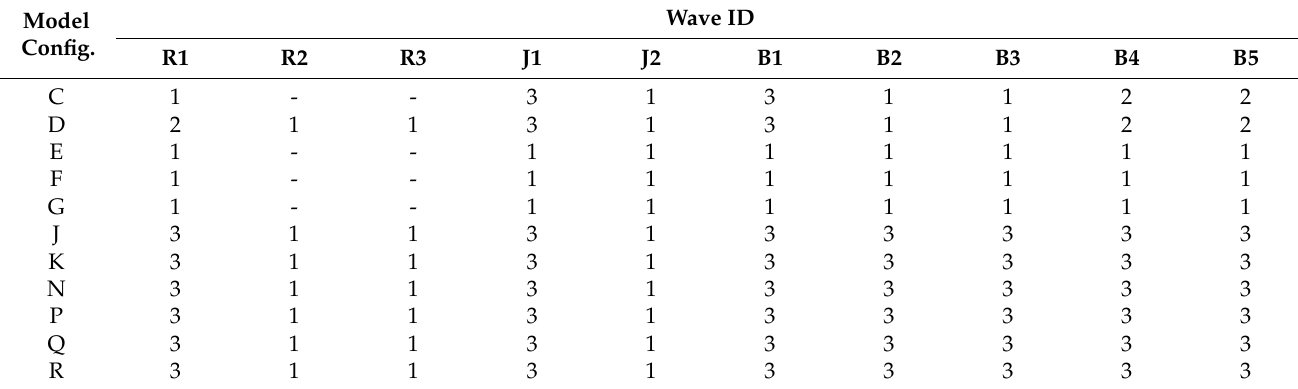
Table 4. Test matrix referencing all waves tested across the different configurations. The number entries indicate the number of repeats performed for each wave-model combination. The symbol “-“ indicates no experiment was performed. Model